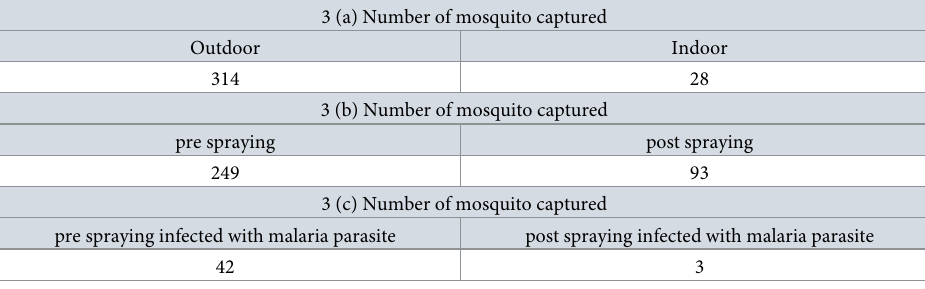
Table 3. Number of mosquitoes collected during the